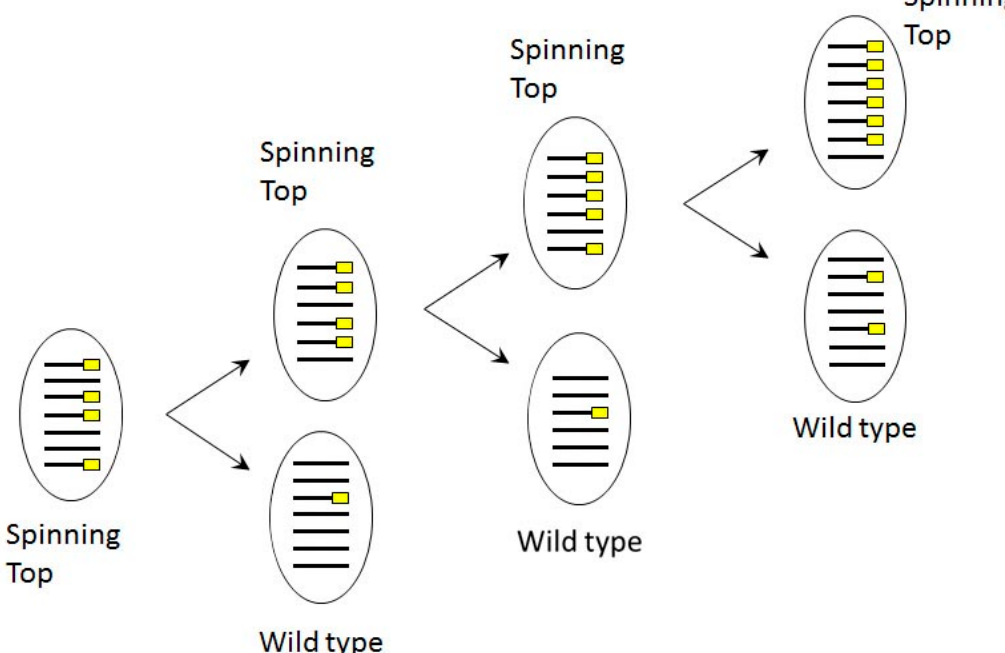
Figure 8. Scheme of copy number dependent phenotype segregation in phenotypically Spinning Top cell line, where MAC deletion was induced in sc1 locus by dsRNA feeding in autogamy. Lines correspond to MAC chromosomes bearing the Spade gene, yellow rectangles indicate chromosome copies with deletions.